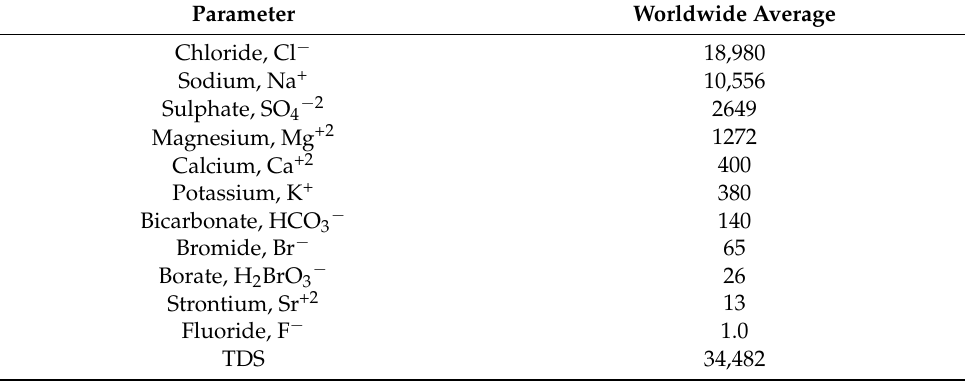
Table 1. Seawater composition: major ion concentration (mg/L) in seawater around the world. Parameter Worldwide Average Chloride, Cl − 18,980 Sodium, Na + 10,556 Sulphate, SO 4 − 2 2649 Magnesium, Mg +2 1272 Calcium, Ca +2 400 Potassium, K + 380 Bicarbonate, HCO 3 − 140 Bromide, Br − 65 Borate, H 2 BrO 3 − 26 Strontium, Sr +2 13 Fluoride, F − 1.0 TDS